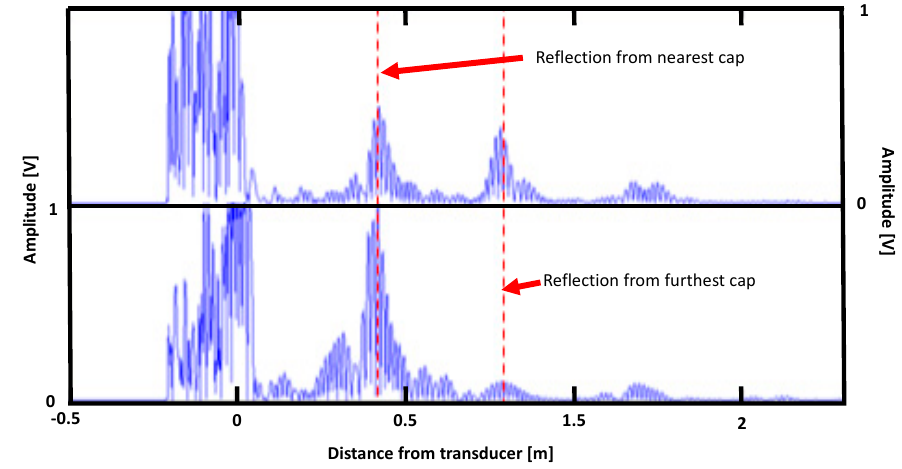
Figure 12. an experimental result corresponding to Figure 10, for a 64 kHz excitation on a real size vessel with the cylindrical part 43 cm long, with the transducer placed either on the cylinder, close to the cap (top of the figure); or on the cap itself (bottom of the figure).